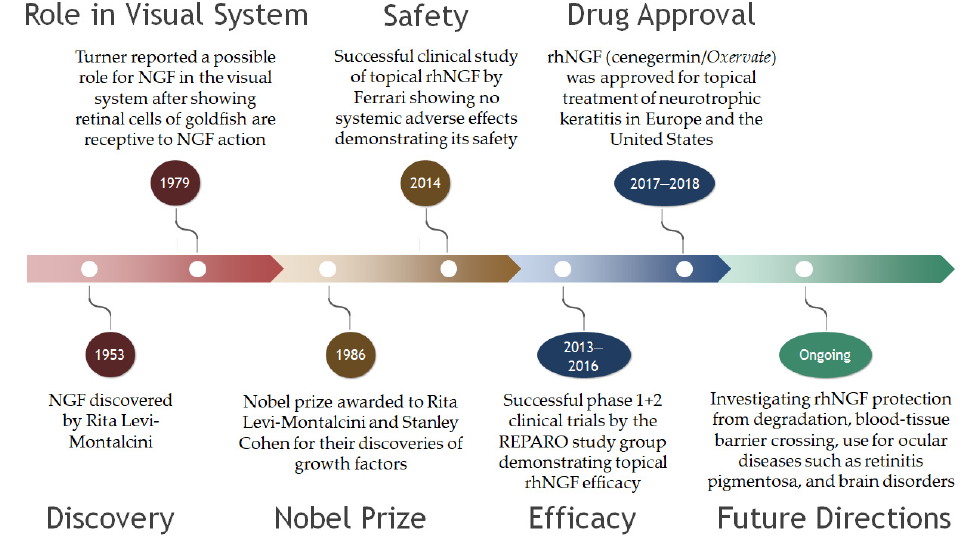
Figure 3. Timeline of the evolution of nerve growth factor from discovery to therapy. NGF, nerve growth factor; rhNGF, recombinant human nerve growth factor.